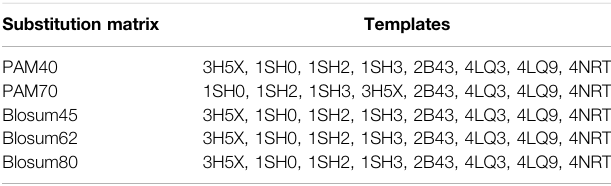
TABLE 2 | Details of different substitution matrices result in fi nding a template for the HuNoV RdRp sequence. Substitution matrix